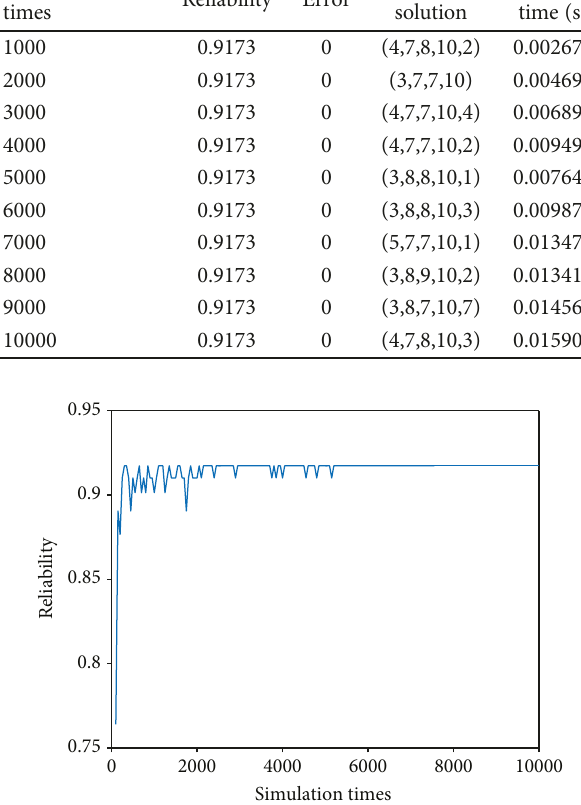
Figure 3: Reliability versus simulation times in the UMOM.